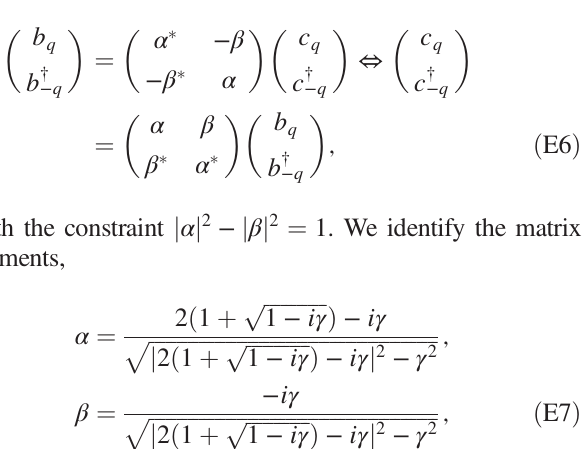
ffiffiffiffiffiffiffiffiffiffiffiffi p 1 − i γ